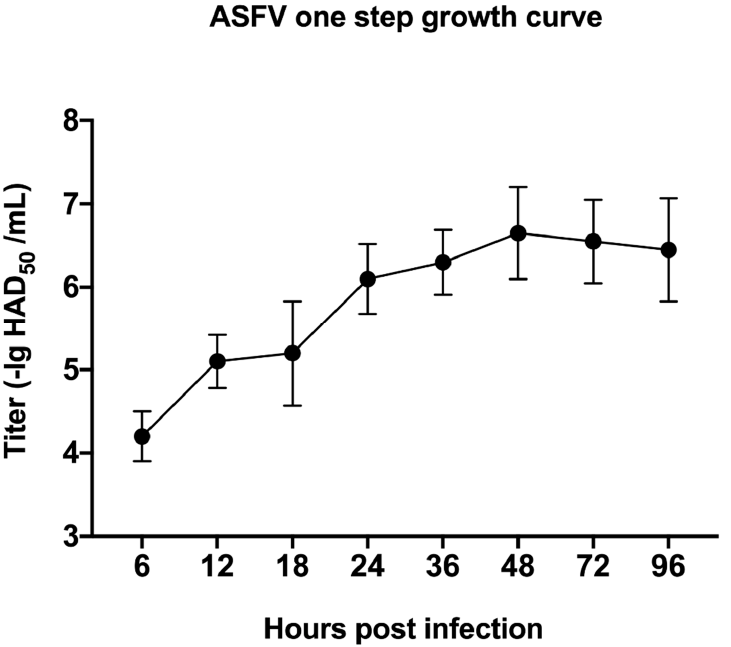
Figure 2. One-step growth curve of ASFV measured through the HAD 50 end-point dilution assays at 6, 12, 18, 24, 36, 48, 72, and 96 h p.i. Cells were infected with ASFV at MOI of 1. The data are expressed as mean ± SD from triplicate measurements.